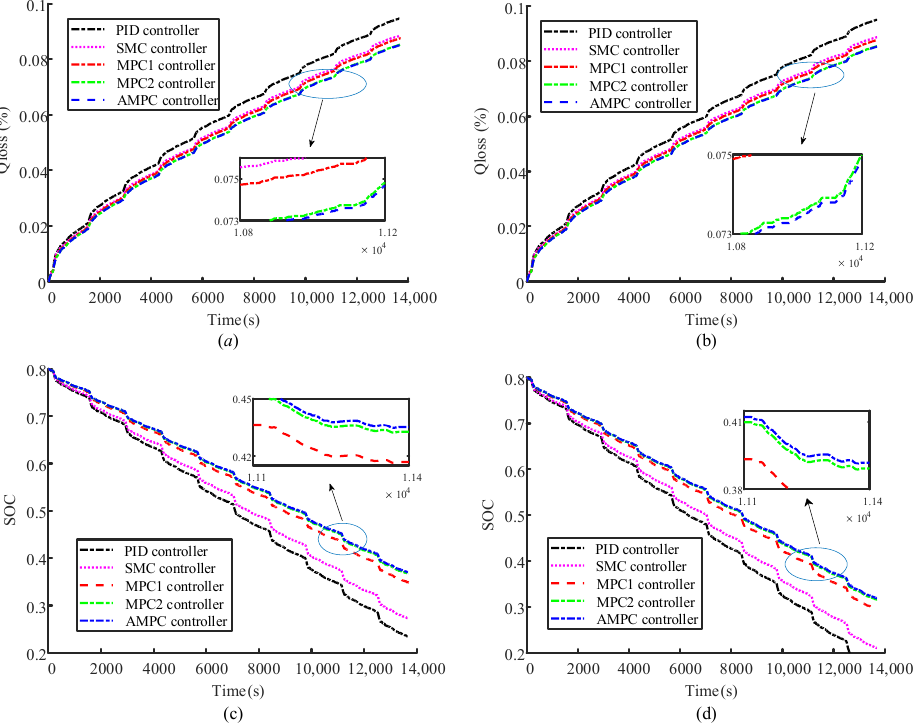
Figure 17. Under 10 UDDS cycles, the battery parameters under the action of each controller: when SOH = 1, ( a ) ba tt ery capacity loss ( c ) SOC. When SOH = 0.9, ( b ) ba tt ery capacity loss ( d ) SOC.